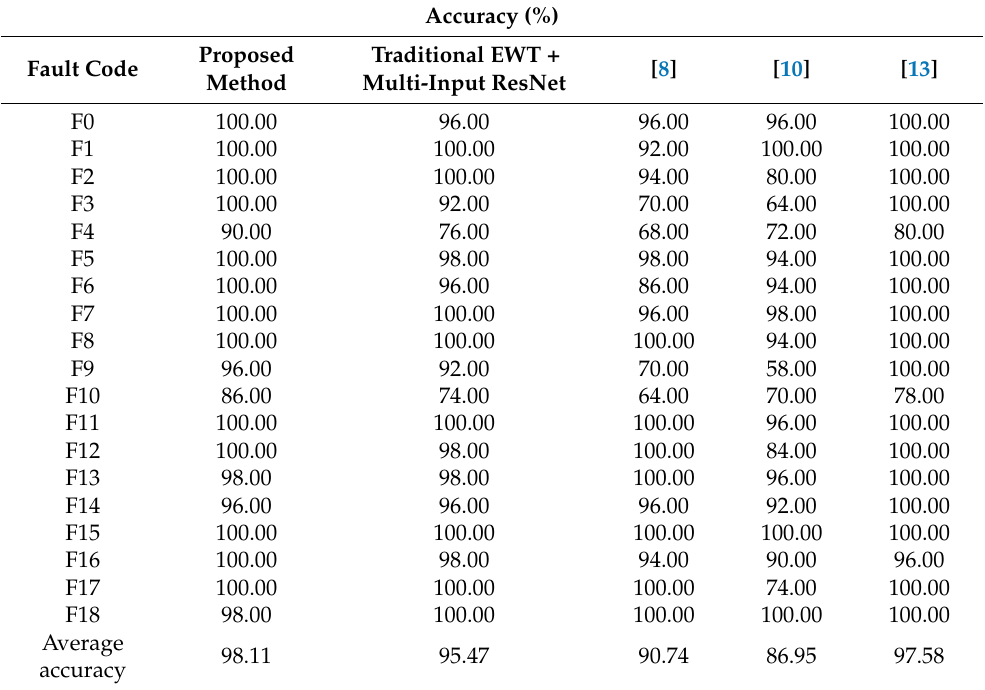
Table 7. Fault diagnosis result of the leap-frog low-pass filter